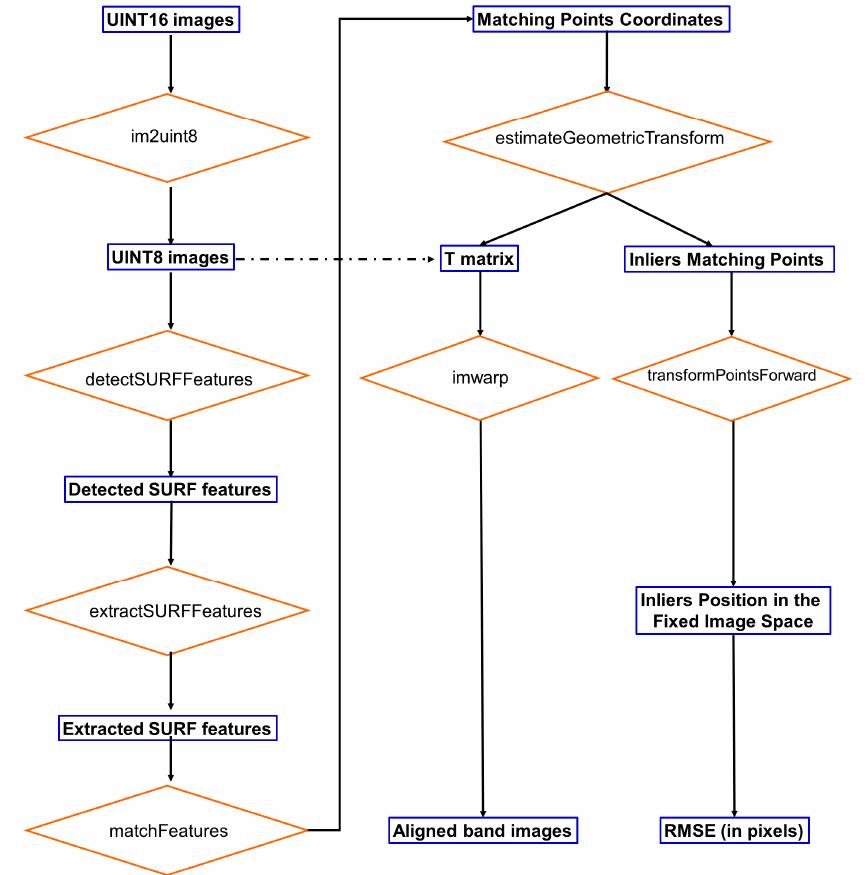
Figure 3. Flowchart of the image registration methodology used in this study to register close- range non-georeferenced images acquired with the MicaSense ® RedEdge multispectral camera over cucumber plants.